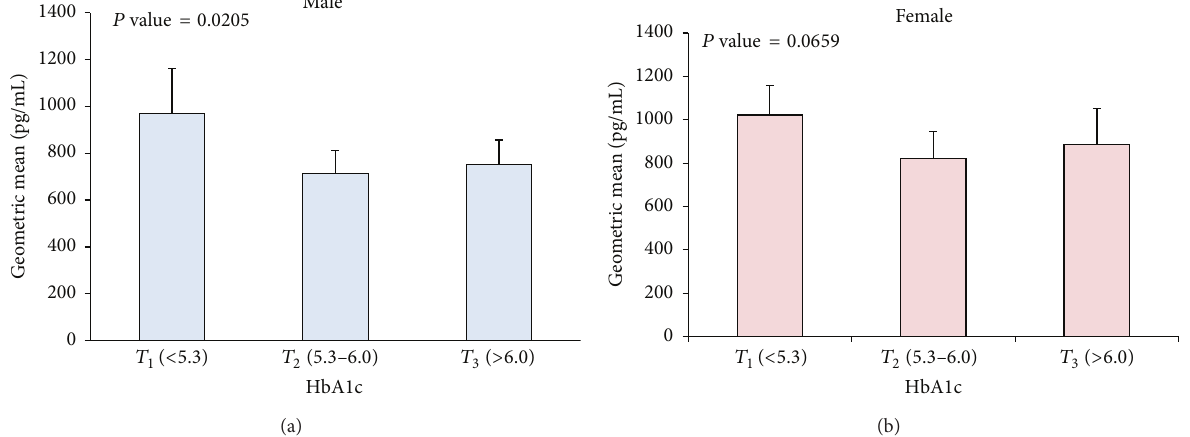
Figure 2: Age and BMI adjusted geometric means of ghrelin level and their effect on HbA1C. (a) Age and BMI adjusted ghrelin levels according to tertiles of HbA1C ( 𝑇 1 < 5.3, 5.3 ≤ 𝑇 2 ≤ 6.0, and 𝑇 3 > 6.0) showing association between decreasing level of HbA1C and decreasing ghrelin level in males ( 𝑃 -trend = 0.0205). (b) Age and BMI adjusted ghrelin levels according to tertiles of HbA1C showing weak but not significant decrease in HbA1C as ghrelin level decreases in females ( 𝑃 -trend =